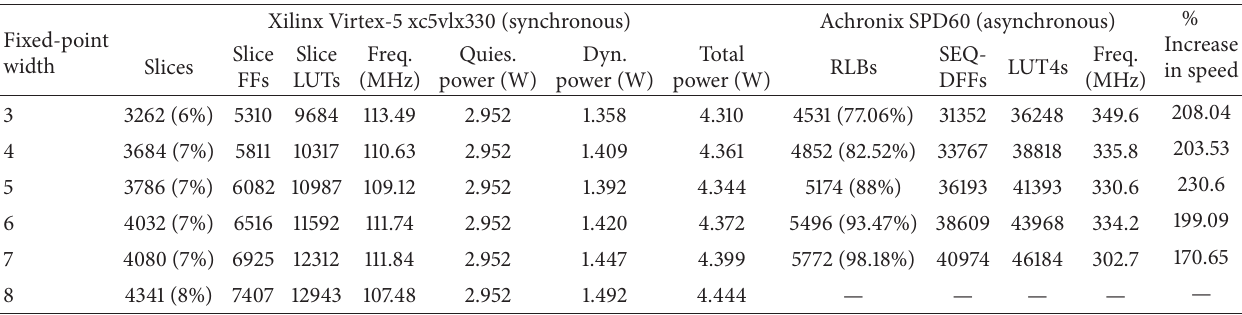
Table 4: Resource utilization, speed of operations, and power consumption of the DCT design on synchronous FPGA and asynchronous FPGA implementations for various input fixed-point bus